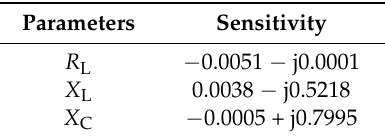
Table 2. Mode sensitivity analysis of the modified system.